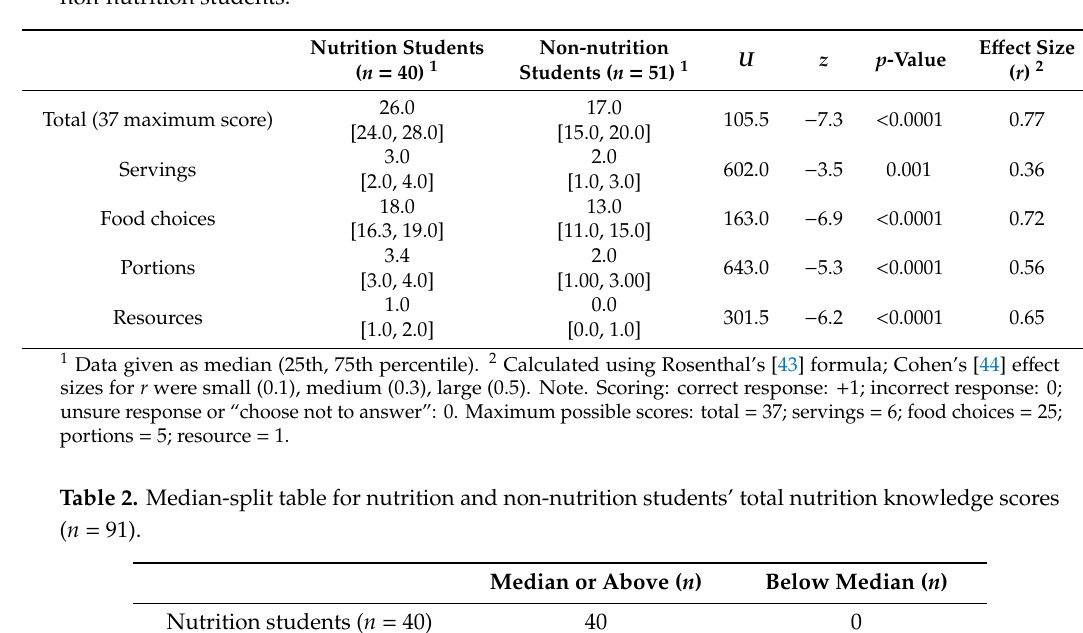
Table 1. Mann-Whitney-U test comparing nutrition knowledge scores between nutrition and non-nutrition students.